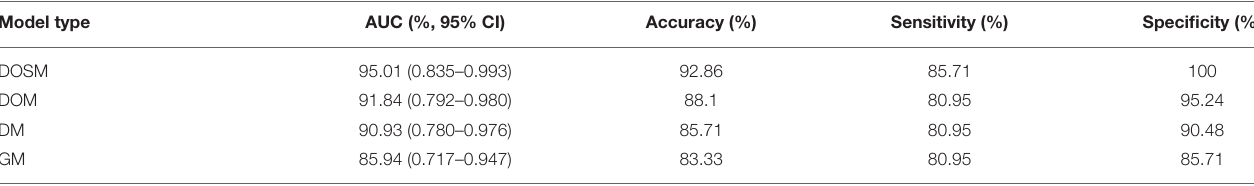
AUC, area under the receiver operating characteristic curve; DOSM, MVI prediction model based on DEA feature map, OND feature map and SDSD feature map of ORF signals; DM, MVI prediction model based on DEA feature map; DOM, MVI prediction model based on DEA feature map and OND feature map; GM, MVI prediction model based on gray-scale ultrasound